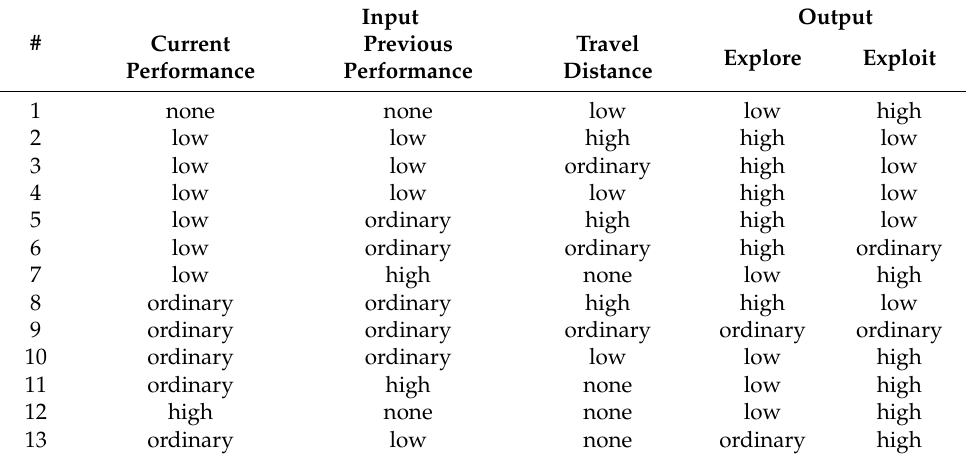
Table 2. Rule base of the fuzzy logic inference system (FIS) used for dynamic search strategy